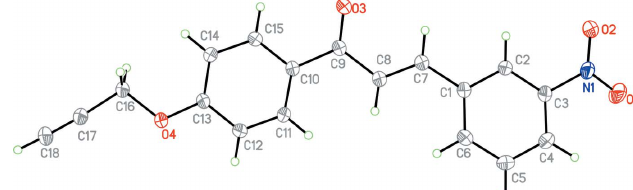
Figure 1 Diagram of molecules showing the atom-labelling scheme. Atomic displacement parameters are at the 30% probability